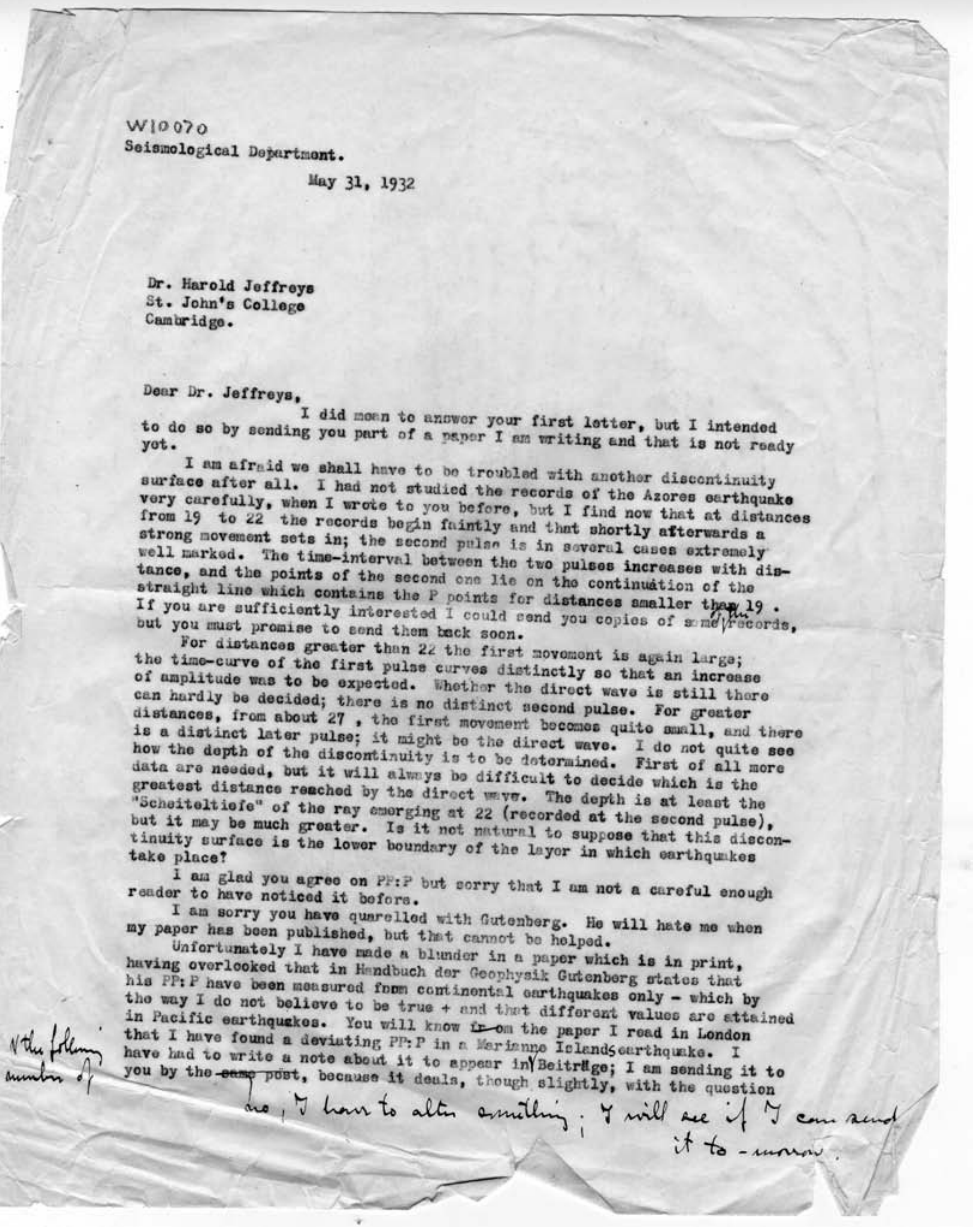
Fig. 2. First page of Inge Lehmann’s May 31, 1932 letter. She offers to send records of the Azores earthquake that shows the discontinuity in the upper layers using the records at distances from 19 to 22